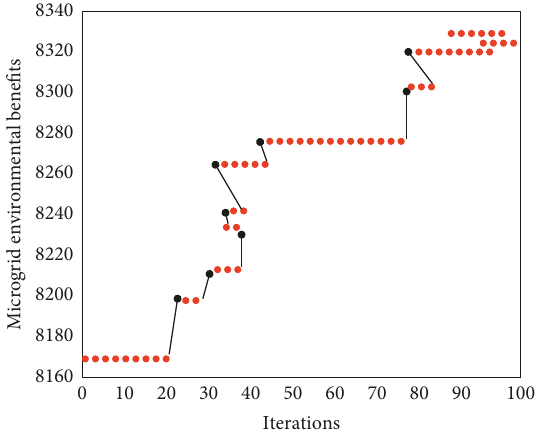
Figure 9: The optimization curve of the environmental benefit of the island microgrid in the 39th period.